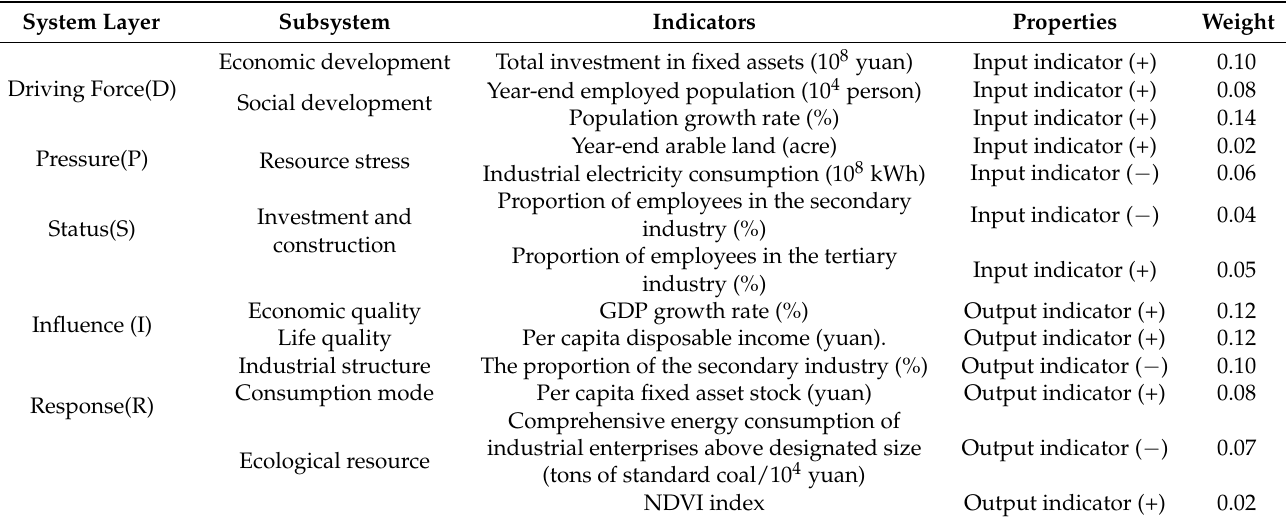
Table 2. Index system for evaluating the development performance of small towns in Jiangyin and indicator